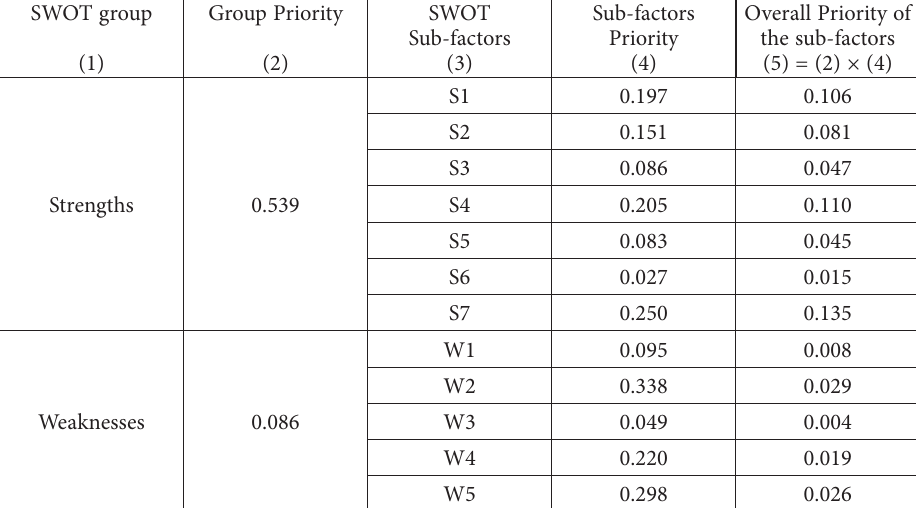
Table 8. Overall